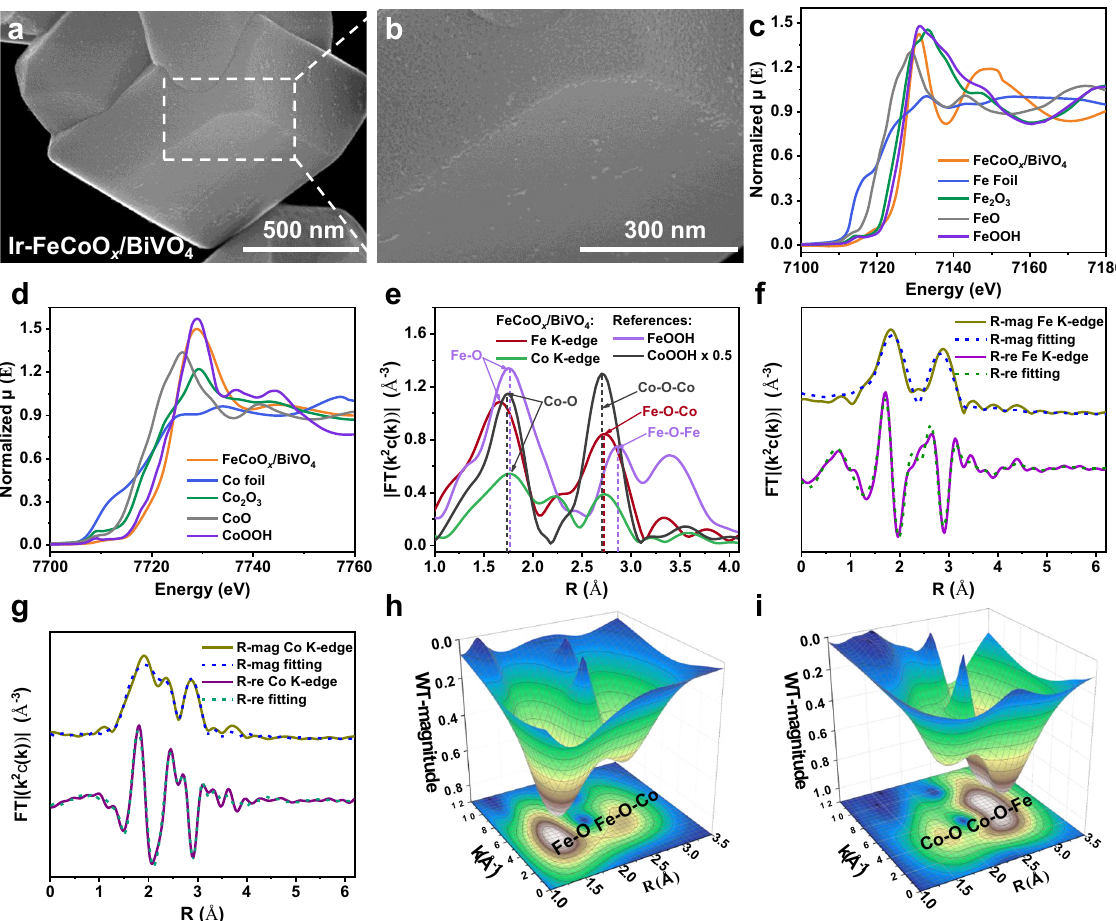
Fig. 2 Morphology and structural characterizations of typical samples. a , b FESEM images of the Ir-FeCoO x /BiVO 4 with different magni fi cation times. c – i Structural characterizations of the FeCoO x /BiVO 4 sample together with references: c Normalized Fe K-edge XANES μ (E) spectra. d Normalized Co K-edge XANES μ (E) spectra. e Fe K-edge and Co K-edge radial distance χ (R) space spectra. f Fourier-transformed (FT)-Extended X-ray absorption fi ne structure (EXAFS) fi tting curves at R space of Fe K-edge. g FT-EXAFS fi tting curves at R space of Co K-edge. h Fe K-edge 3D contour wavelet transform. i Co K-edge 3D contour wavelet